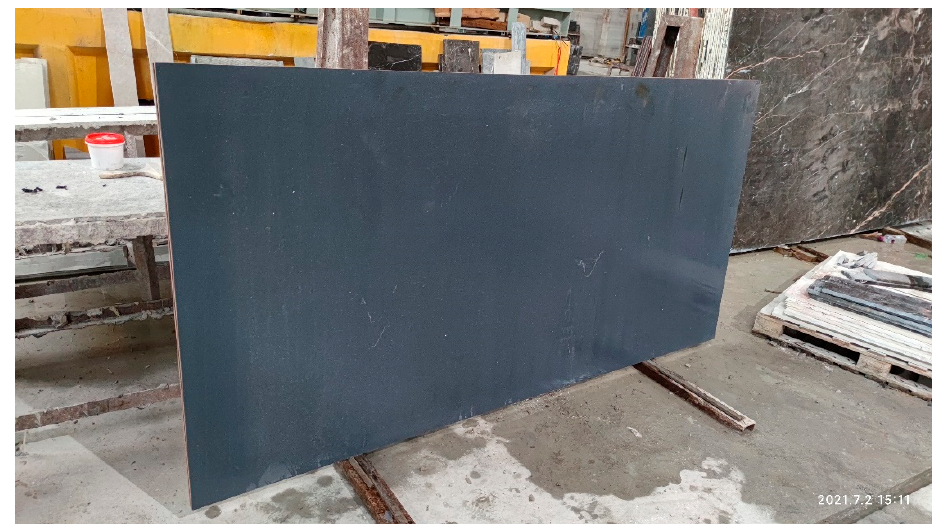
Figure 8. Shrinkage curve as a function of time.